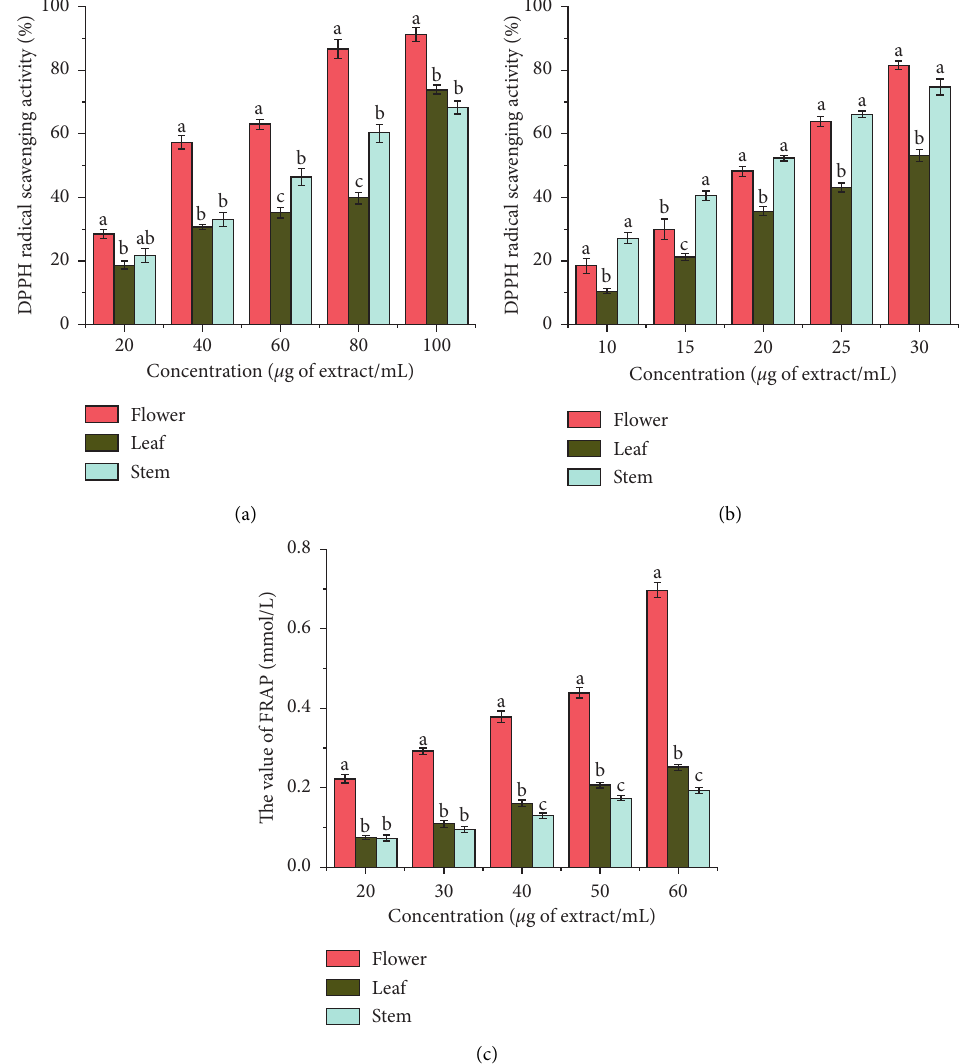
Figure 2: The antioxidant activities of the flower, leaf, and stem extracts of Prinsepia utilis Royle. (a) DPPH radical scavenging activity, (b) ABTS radical scavenging ability, and (c) ferric reducing antioxidant power (FRAP). All the values are expressed as mean ± SD ( n � 3). Values with different superscript letters in each column indicate significant differences among samples ( p < 0 . 05).